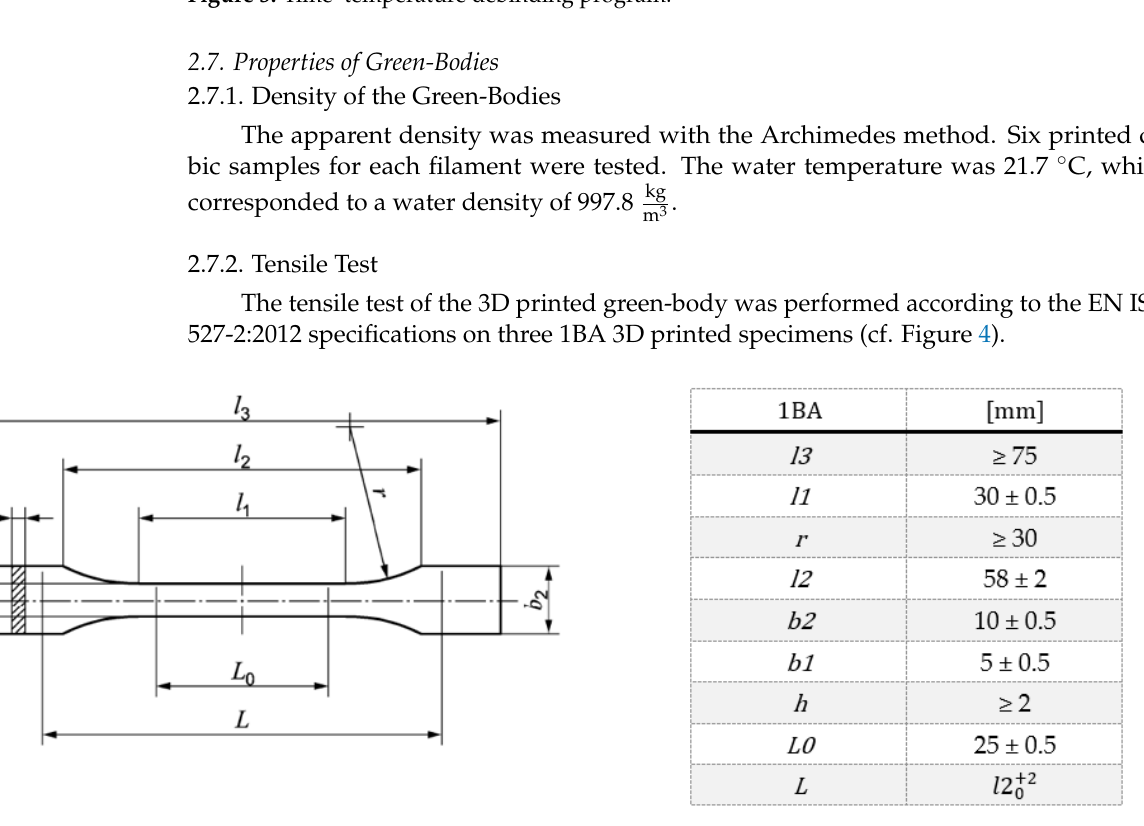
Figure 3. Time–temperature debinding program.